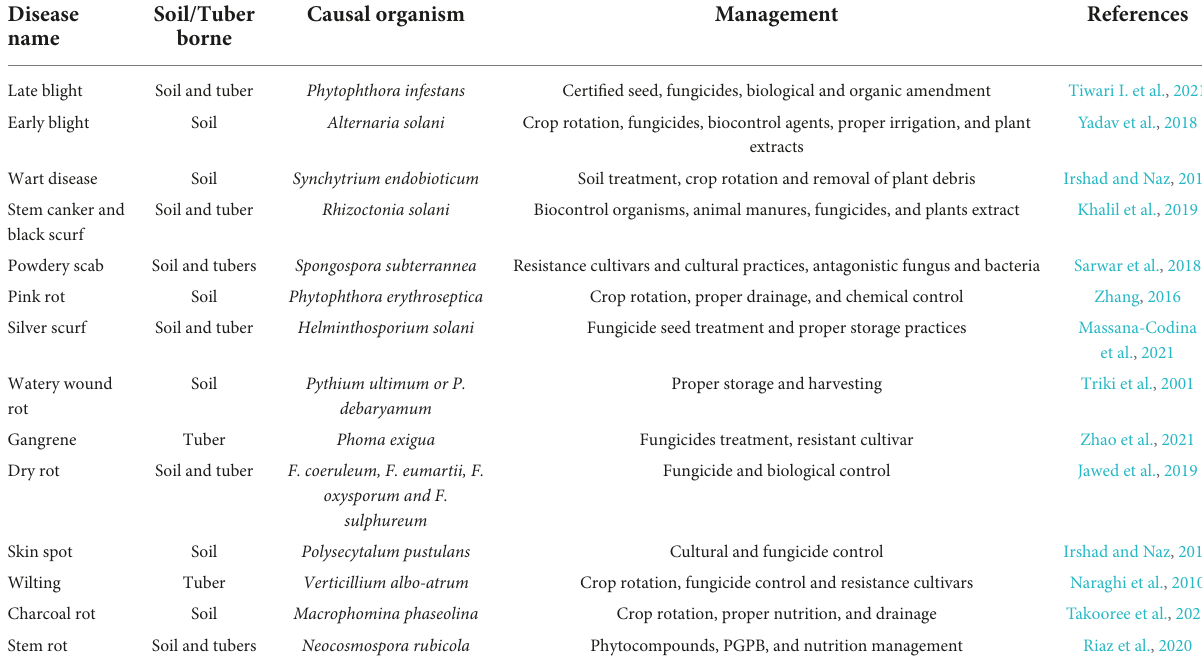
TABLE 1 Important fungal diseases of potato and their prospective management